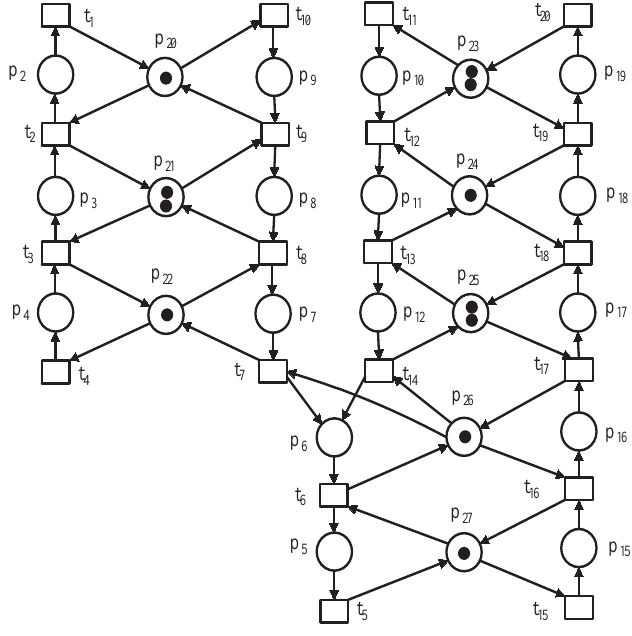
Figure 12. A subnet model for ( N (cid:48) , M 0 ) .